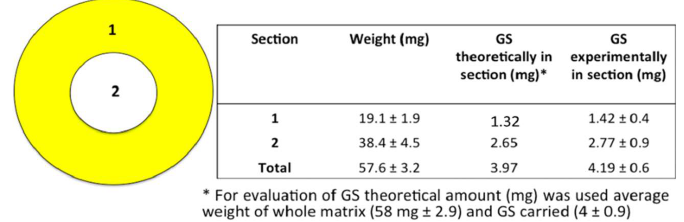
Figure 5. GS quantification in matrices portions.